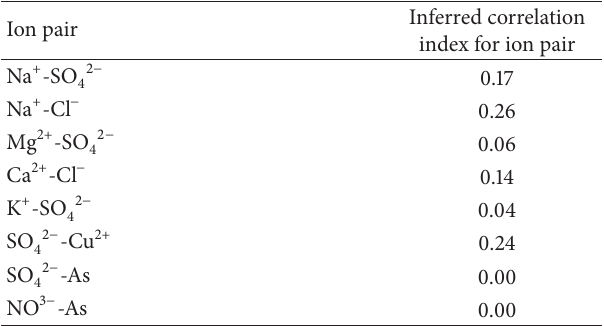
Table 3: Calculated ion pair correlation